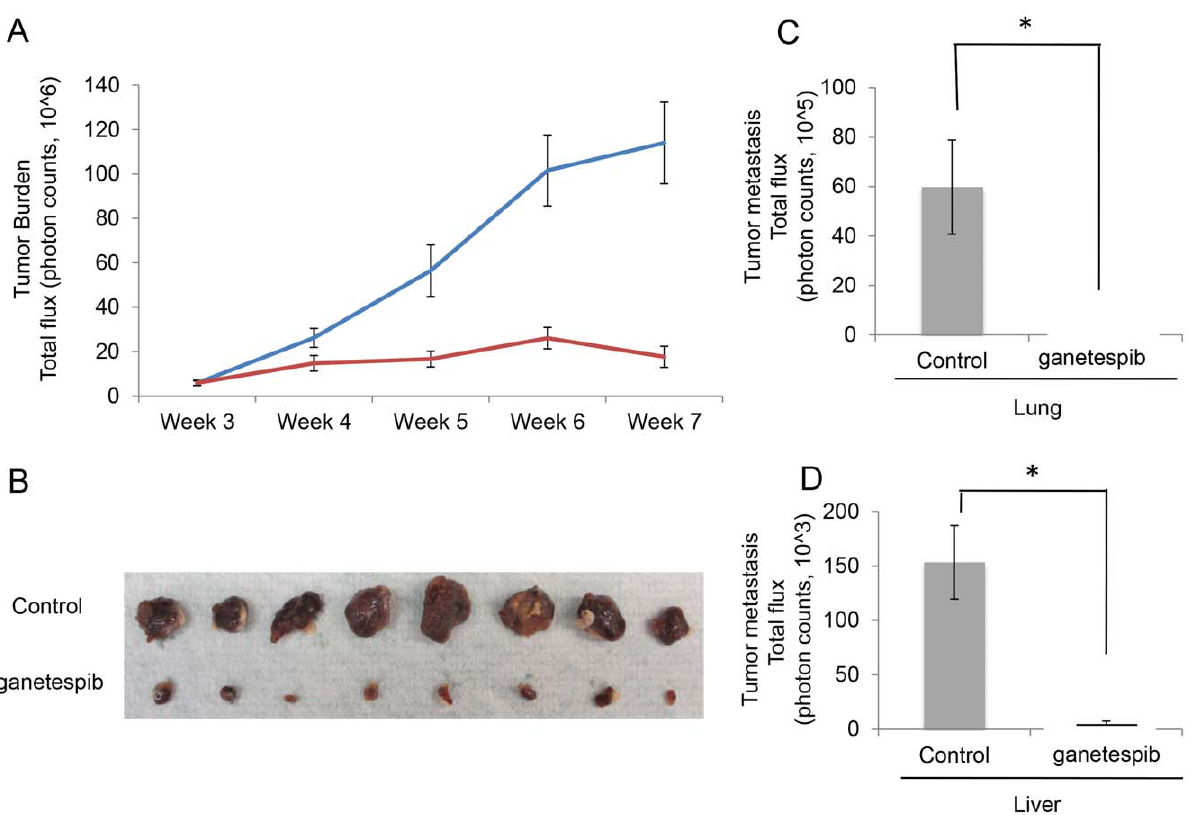
Figure 5. Ganetespib inhibits tumor metastasis in a spontaneous metastatic pheochromocytoma model. A) Efficacy of ganetespib in an MTT-luc subcutaneous model of pheochromocytoma. Quantification of tumor growth was determined by luciferase measurement in an IVIS instrument. Data are plotted as mean photon counts (total flux) from regions of interest (ROI). Error bars represent standard deviations. B) Primary tumors excised from the two groups were compared. C and D) Ex vivo bioluminescence signals from lung and liver were compared between the two groups and graphed as total flux as a method of quantification of metastatic burden at the end of the experiment (*p , 0.05).